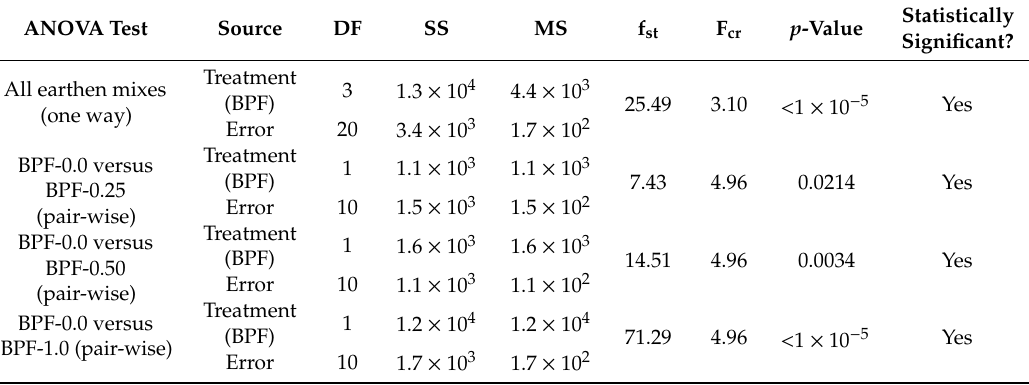
Table 8. 5% significance level ANOVA tests for the impact strength at the first crack of earthen mixes.